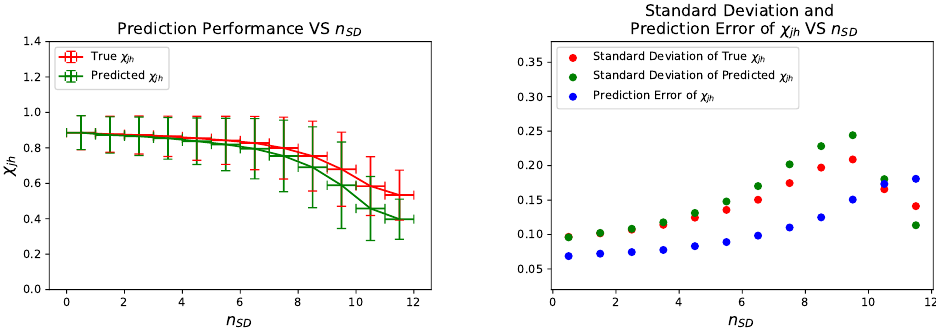
Figure 27 . Prediction Performance (left panel) and Standard Deviation, Prediction Error (right panel) VS n SD